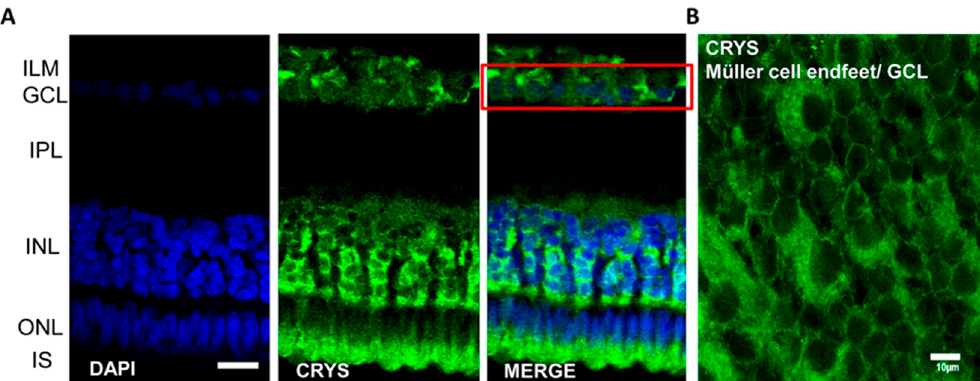
Figure 1. Immunolocalization of α A-crystallin in the caiman retina. ( A ) α A-crystallin (CRYS, green) is expressed in the inner nuclear layer (INL) surrounding the nuclei of neurons (DAPI nuclear staining, blue). Crystallin is also localized surrounding ganglion cell nuclei (red box) in the ganglion cell layer and in the inner segment area of photoreceptors. ( B ) α A-crystallin observed from the top of whole-retina tissue. Crystallin is confined to the endfeet of Müller cells in the ganglion cell layer (white arrow). IPL, inner plexiform layer; ILM, inner limiting membrane; GCL, ganglion cell layer; INL, inner nuclear layer; ONL, outer nuclear layer; IS, inner segments of photoreceptors. Scale bar in A, 20 µ m and in B, 10 µ m.